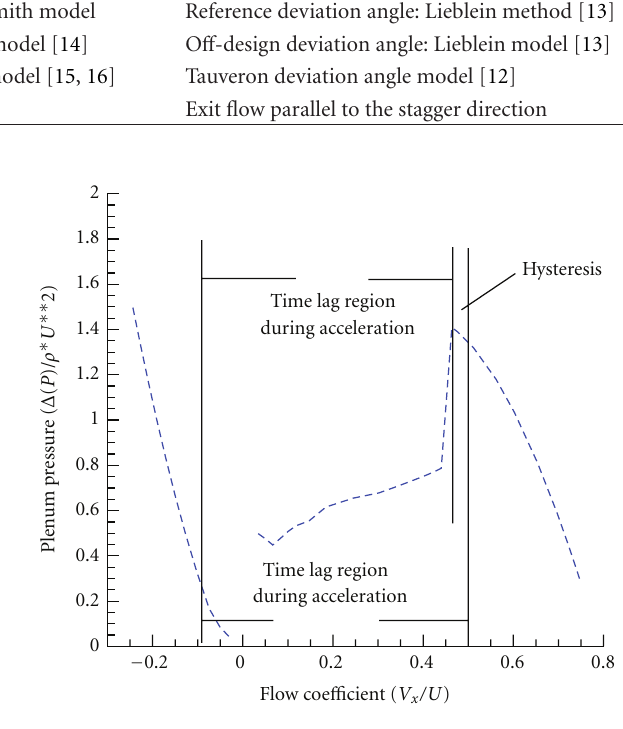
Figure 2: Application of time lag for the dynamic force.